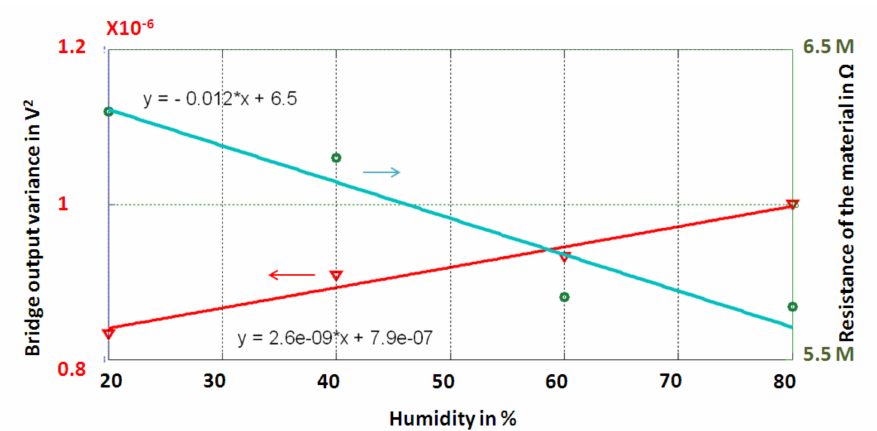
Figure 12. Validation of the redundant principle. It is possible to measure the humidity by using the variation of the output bridge (for a fixed mechanical excitation frequency) and the variation of the resistance of the GO /